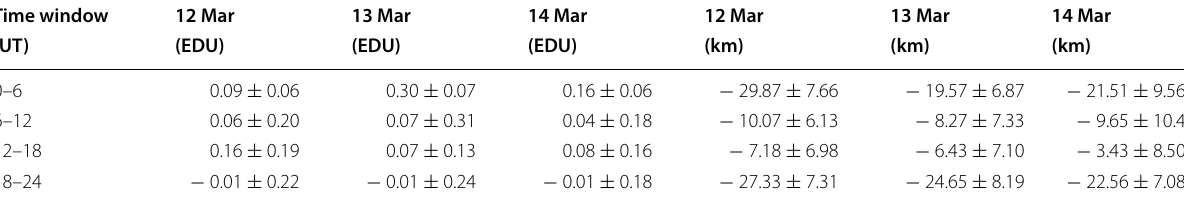
Table 1 Mean deviations with respect to N UT to March 14, 24:00 UT,